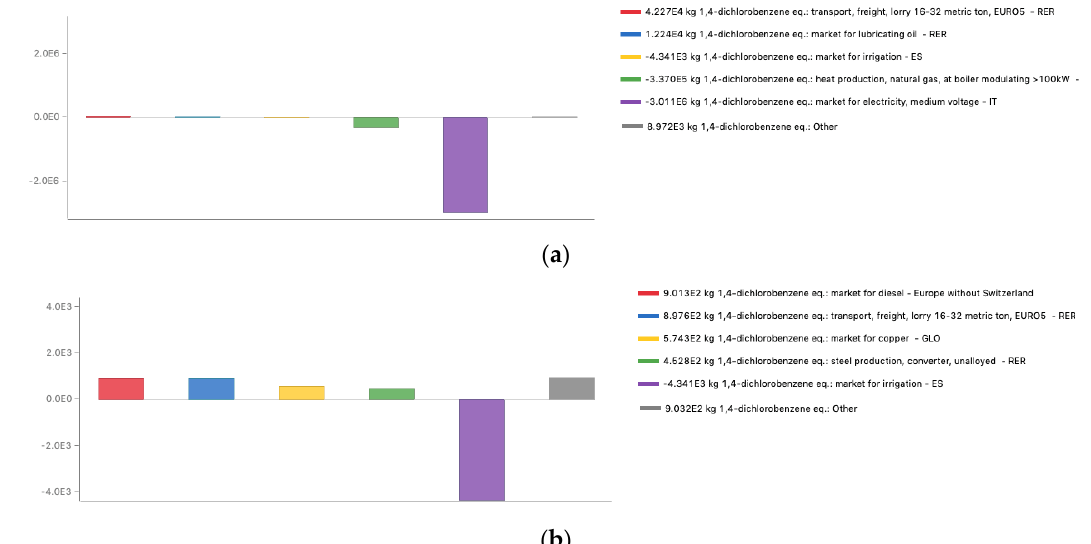
Figure 10. Marine aquatic ecotoxicity: top 5 contributions impacting category results: ( a ) Cradle-to-grave analysis; ( b ) Downstream process.